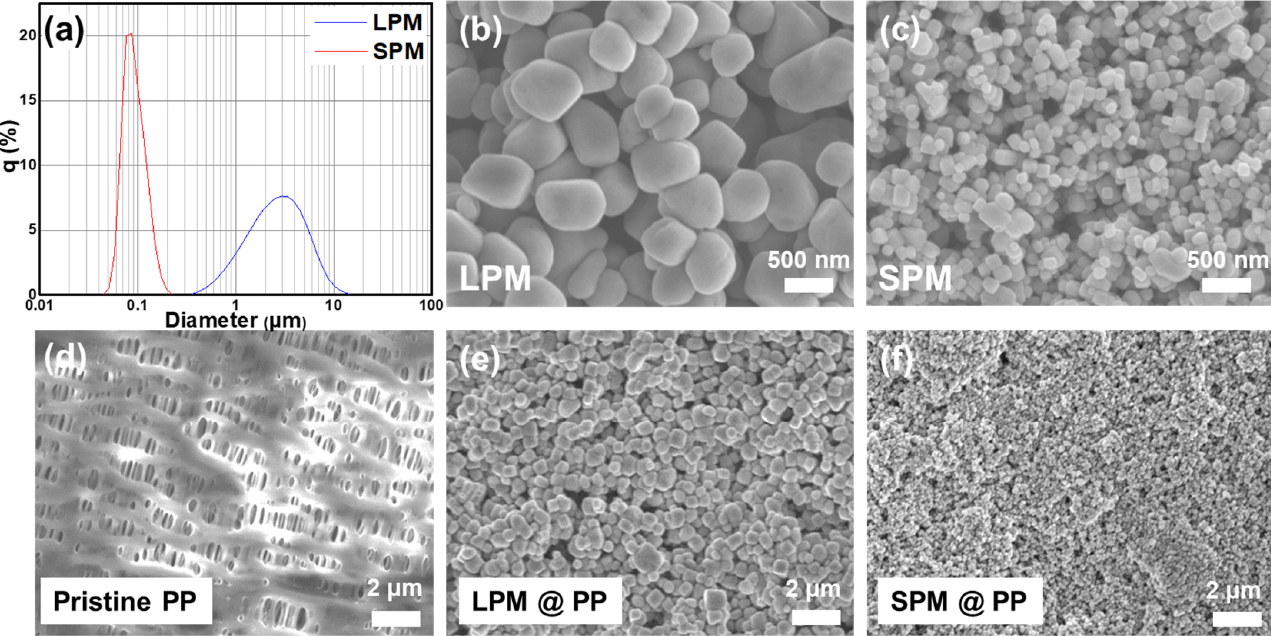
Figure 2. ( a ) Particle size distribution of LPM and SPM; ( b – c ) SEM images of LPM and SPM,